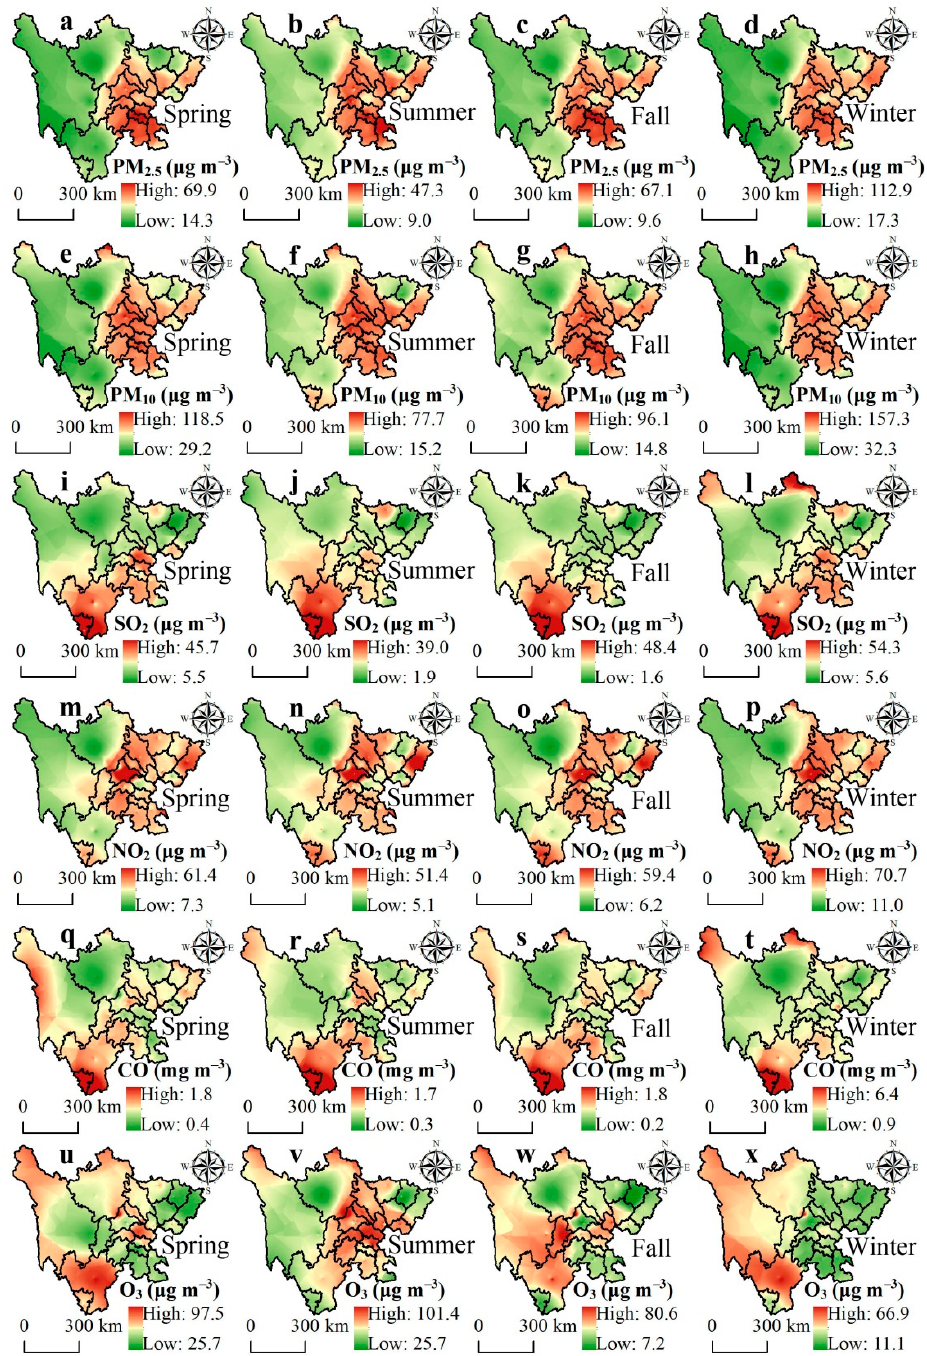
Figure 3. Spatial patterns of the six criteria air pollutants showing the seasonal mean concentrations from 2015 to 2017: ( a ) PM 2.5 *, ( e ) PM 10 *, ( i ) SO 2 *, ( m ) NO 2 *, ( q ) CO # , and ( u ) O 3 * in spring; ( b ) PM 2.5 *, ( f ) PM 10 *, ( j ) SO 2 *, ( n ) NO 2 *, ( r ) CO # , and ( v ) O 3 * in summer; ( c ) PM 2.5 *, ( g ) PM 10 *, ( k ) SO 2 *, ( o ) NO 2 *, ( s ) CO # , and ( w ) O 3 * in fall; ( d ) PM 2.5 *, ( h ) PM 10 *, ( l ) SO 2 *, ( p ) NO 2 *, ( t ) CO # , and ( x ) O 3 * in winter. Units: * μ g m –3 ; # mg m –3 .